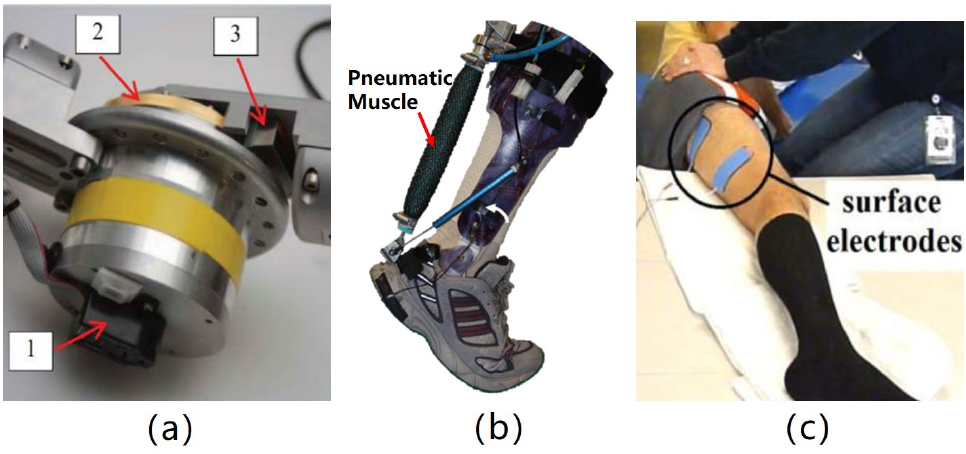
Figure 2. Exoskeleton’s actuators. ( a ) Motor drive, adapted from ref. [33]; ( b ) Air pressure drive reprinted from ref. [29]; ( c ) Self muscle drive, reprinted from ref. [40].